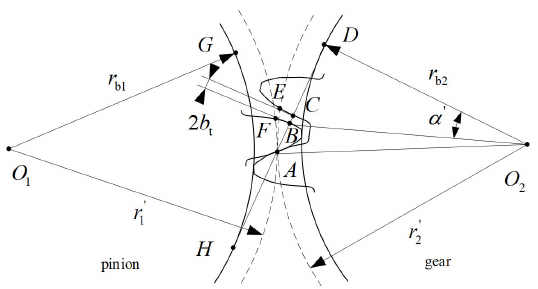
Figure 3. Geometrical relationship between gear backlash and center